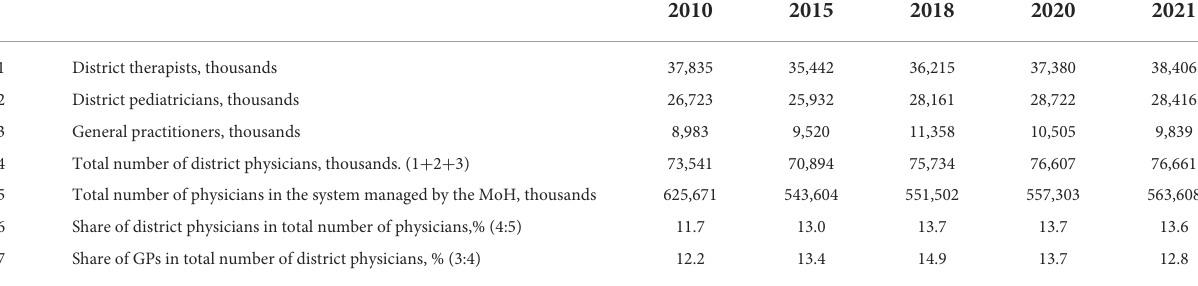
TABLE 3 District physicians in Russia,